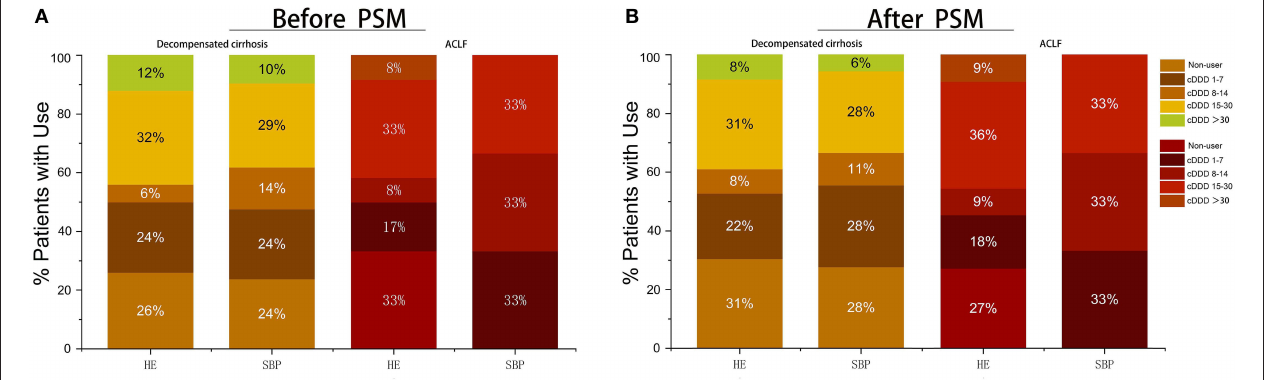
Frontiers in Medicine |